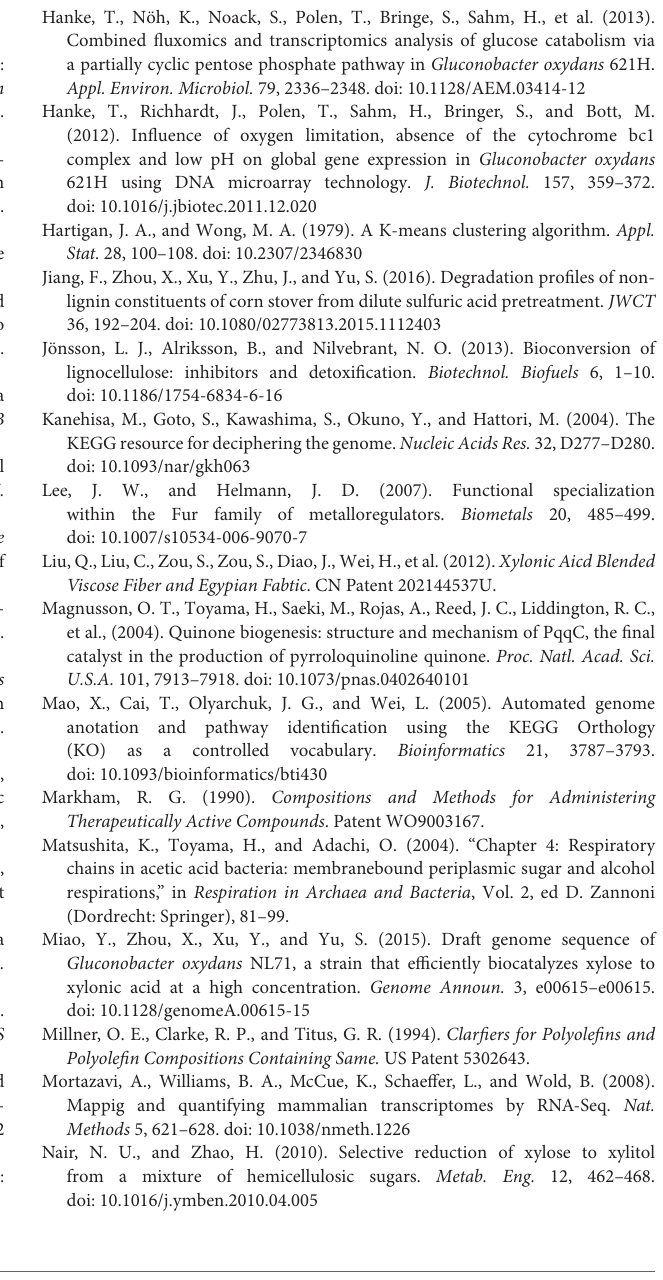
Figure S1 | Quantitative real time-PCR (qRT-PCR) of 19 genes randomly selected for Blank vs. Formic, Blank vs. Furfural, and Blank vs. PHB. The relative expression level was assessed by qRT-PCR and shown by three